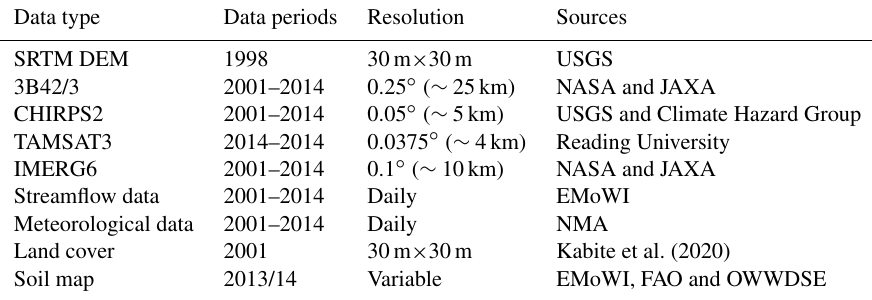
Figure 1. Location map of Dhidhessa River Basin with ground stations (USGS, 1998). Table 1. Data description and